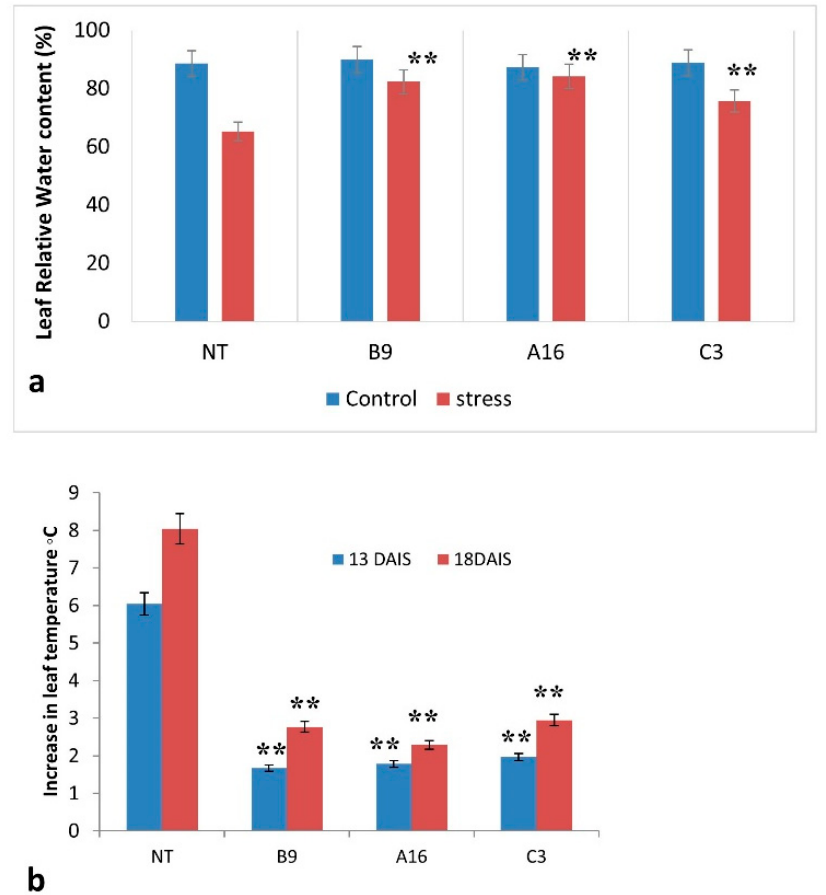
Figure 3. Relative water content (RWC) and temperature (increase over control) in the leaves of transgenic and non- transgenic ADT 43; ( a ) Relative water content measured on 18 DAIS; ( b ) increase in the leaf temperature of stressed plants over controls on 13 DAIS and 18 DAIS; NT, Non-transgenic ADT 43. Values are mean of three replications and ** indicates statistical significance at p < 0.01 (ANOVA compared to non-transgenic data).